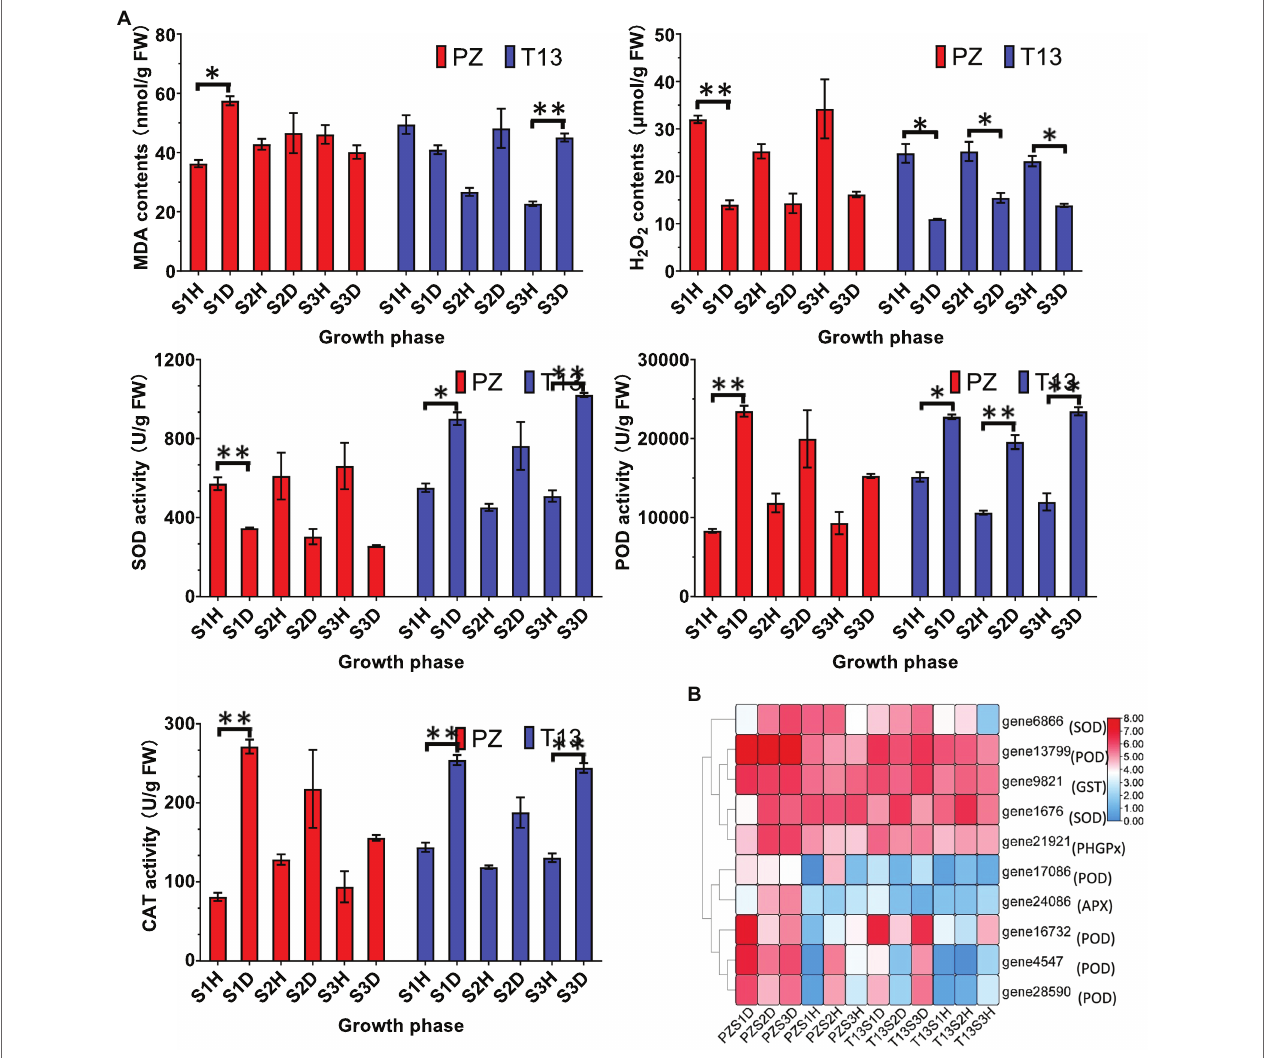
FIGURE 6 | Physiological changes and heatmap of DEGs involved in reactive oxygen species (ROS) in PZ and T13 leaves infected by phytoplasma. (A) The levels of malondialdehyde (MDA) and hydrogen peroxide (H 2 O 2 ) contents and superoxide dismutase (SOD), peroxidase (POD) and catalase (CAT) activities in “PZ” and “T13” leaves in three growth phases in healthy and diseased “PZ” and “T13” with three biological replications. Error bar represents SE ( n = 3). (B) Heatmap of the expression level of key genes involved in the ROS pathway with Log2FC calculation. PZDS1 and T13DS1 represent the samples from the S1 growth phase of diseased “PZ” and “T13,” respectively. The other labels in the heatmap have the corresponding meanings as well as PZDS1 or T13DS1. * p < 0.05; and ** p <